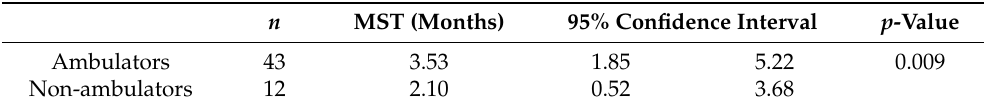
Table 5. Survival time of ambulators versus non-ambulators. n MST (Months) 95% Confidence Interval